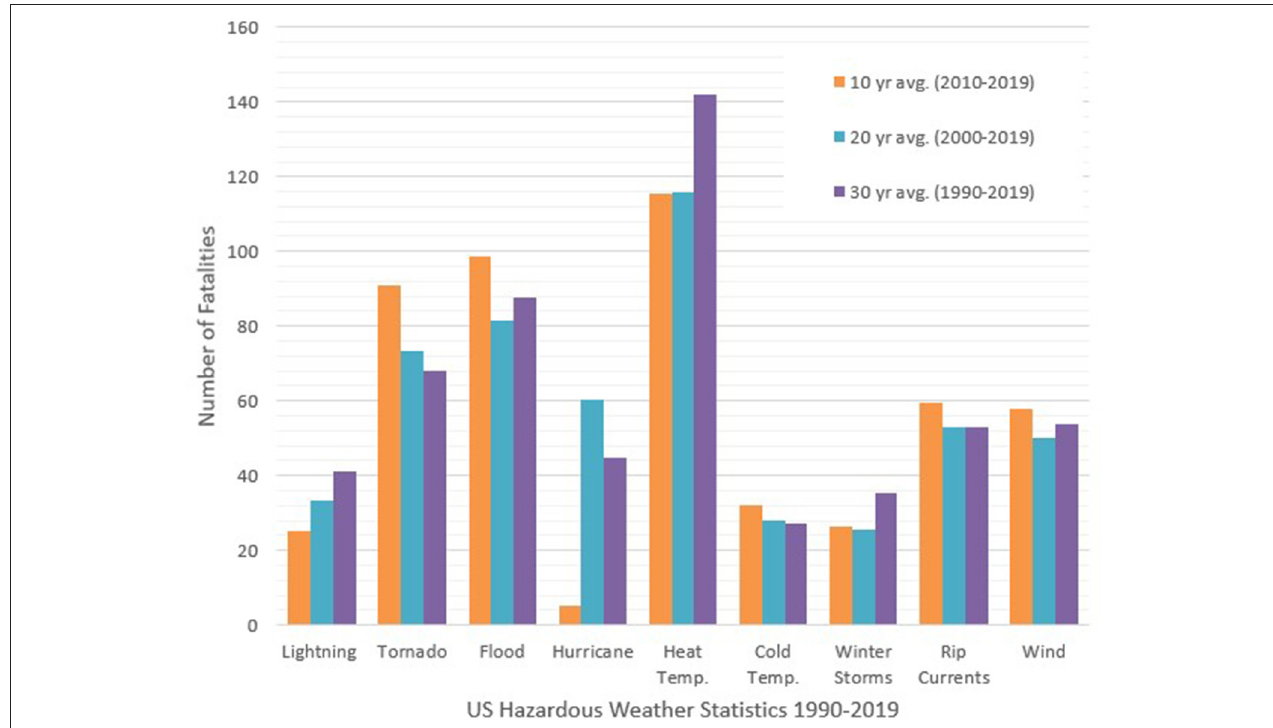
FIGURE 2 | Interacting barriers resulting in hazard Bias in adaptation and mitigation actions.